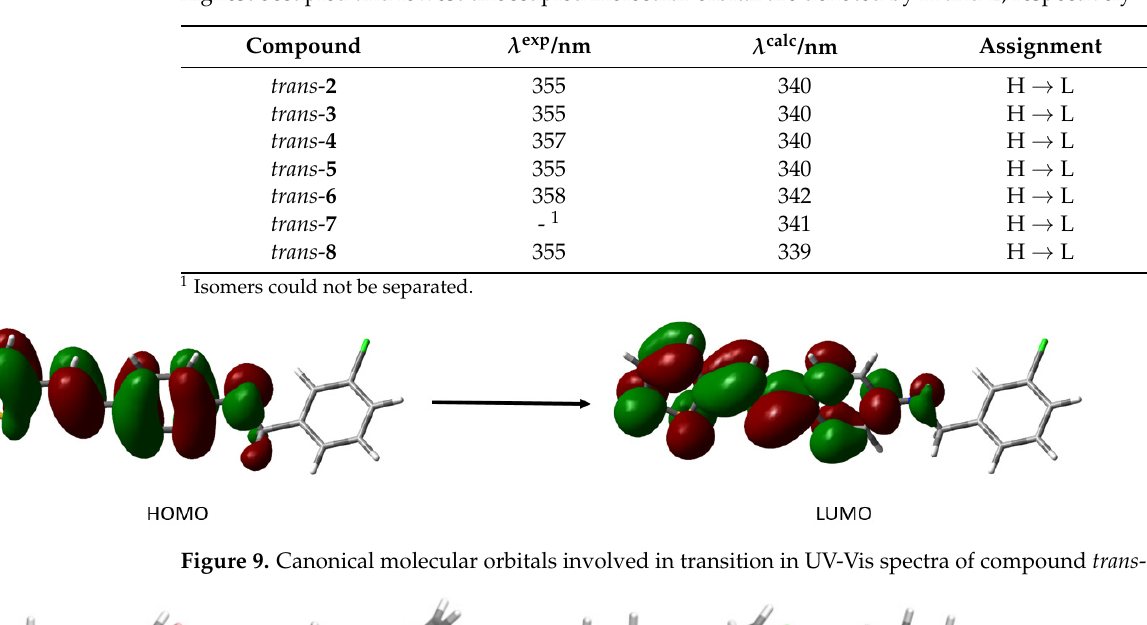
Table 2. Measured and calculated λ max values for trans -styryl-thiophene benzylamines, along with main assignments. Calculated data is obtained at the computational model (CPCM)TD-CAM- B3LYP/6–31++G(d) (ACN), with geometries optimized at the M06-2X/6-31G(d) level of theory. The highest occupied and lowest unoccupied molecular orbital are denoted by H and L, respectively.